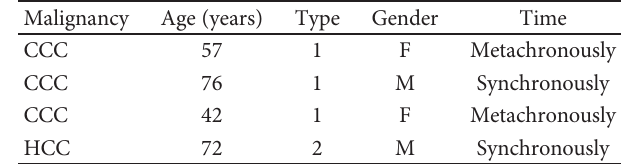
Figure 6: Patients with AIP1 were mainly positive for HLA-B8. However, patients with AIP2 were predominantly positive for HLA-DR4. Table 2: Immunosuppression and relapse data of patients with AIP1 and AIP2.